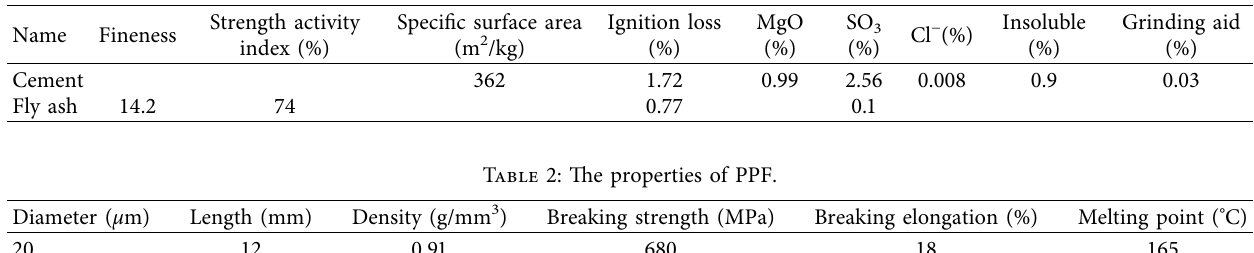
Table 1: Physical properties and chemical composition of cement.